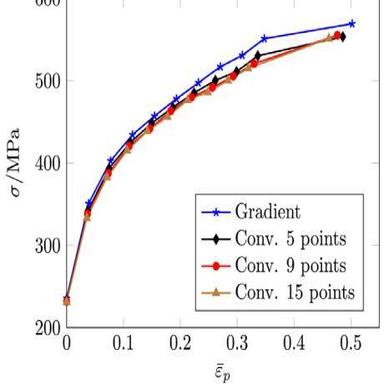
Identified piecewise linear hardening curve with LSSCI method using experimental data from notched specimen at 0∘ .